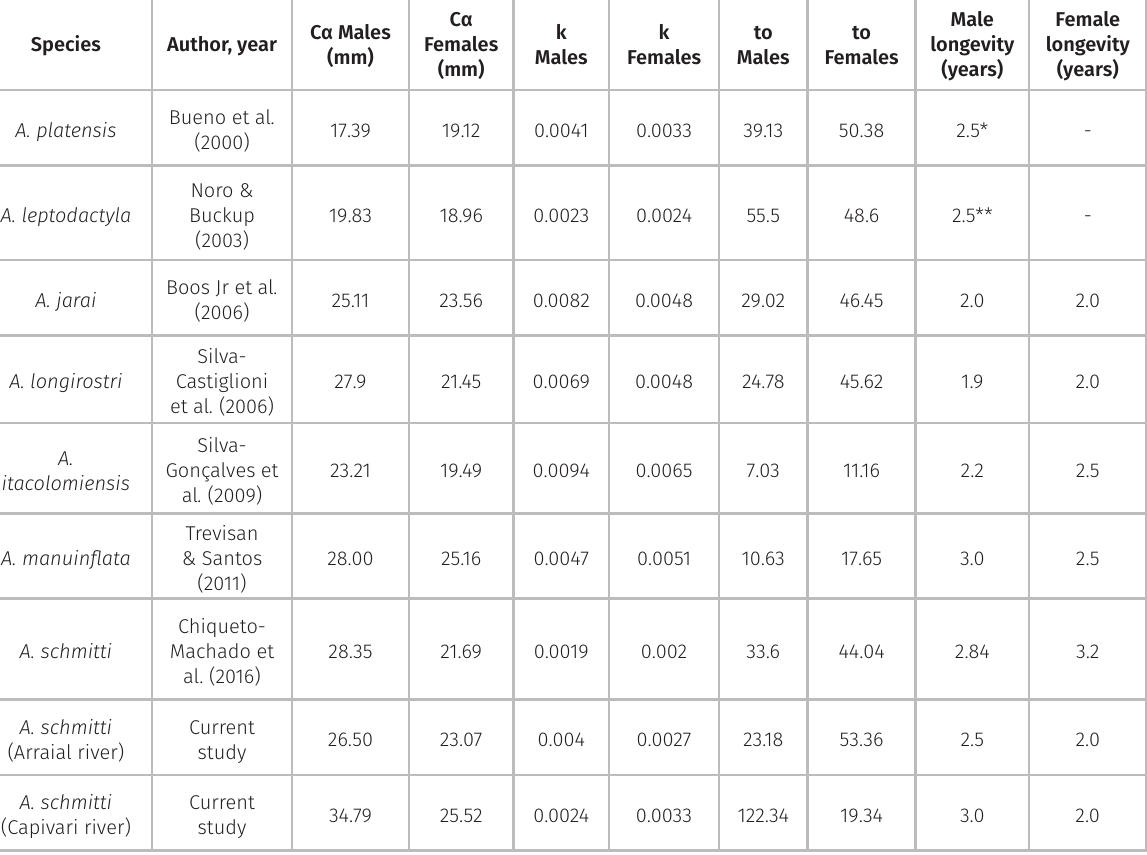
Table III. Comparison of the values of the components of the von Bertalanffy growth equations in studied species of Aegla . Cα : mean maximum carapace length; k : growth rate; to : life time (in days) of the smallest specimen sampled; L∞ :